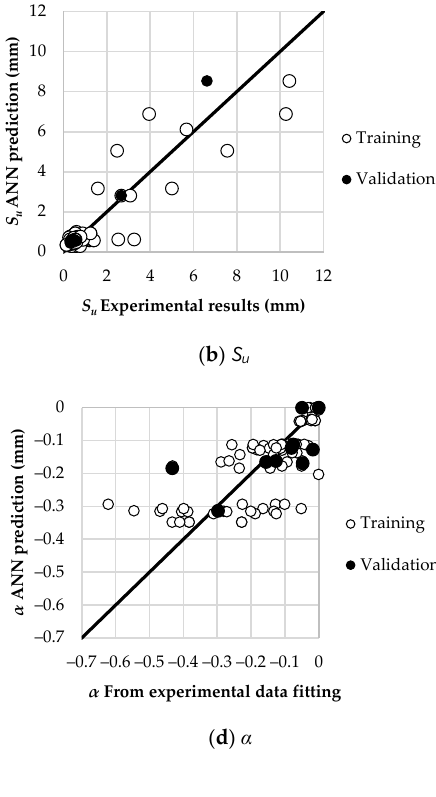
Figure 6. Training and validation results of the 5-9-4 ANN1 model versus experimental data.